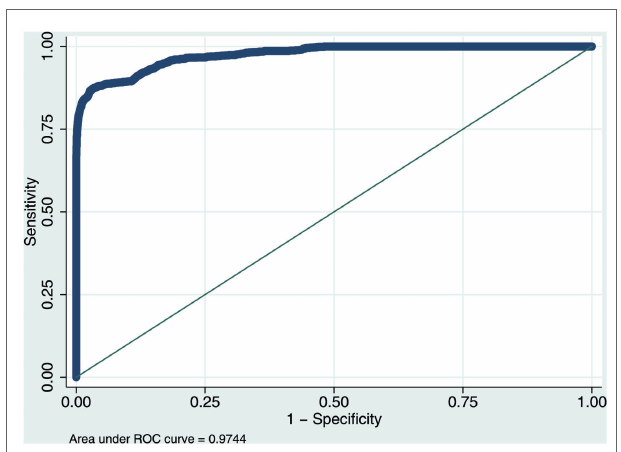
FIGURe 3 | RoC curve for a subset of 1,000,000 randomly selected data points comparing the trade-off between sensitivity and specificity of the logistic regression model’s performance for predicting transitions to a higher level of care